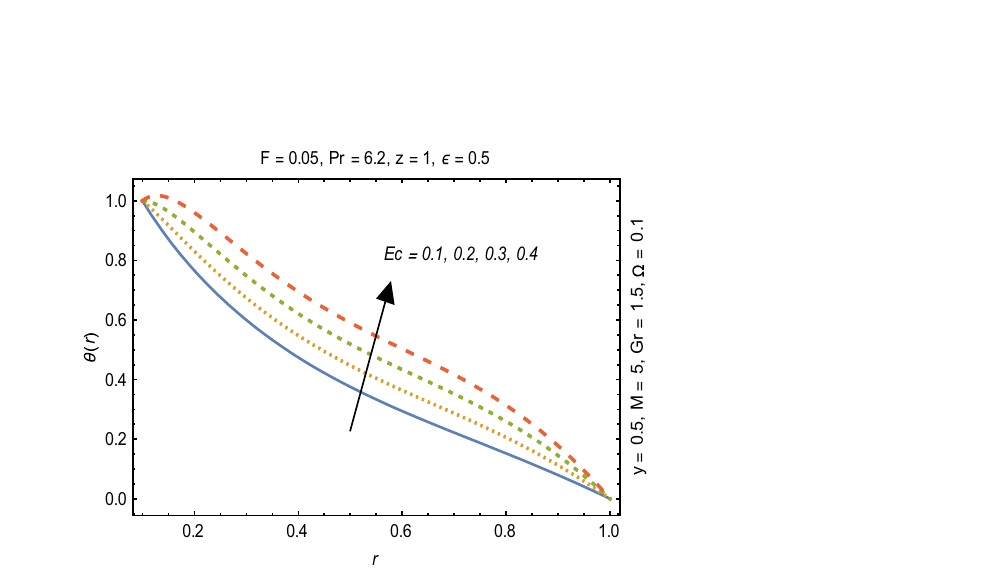
Figure 7. Variation in θ (r) against